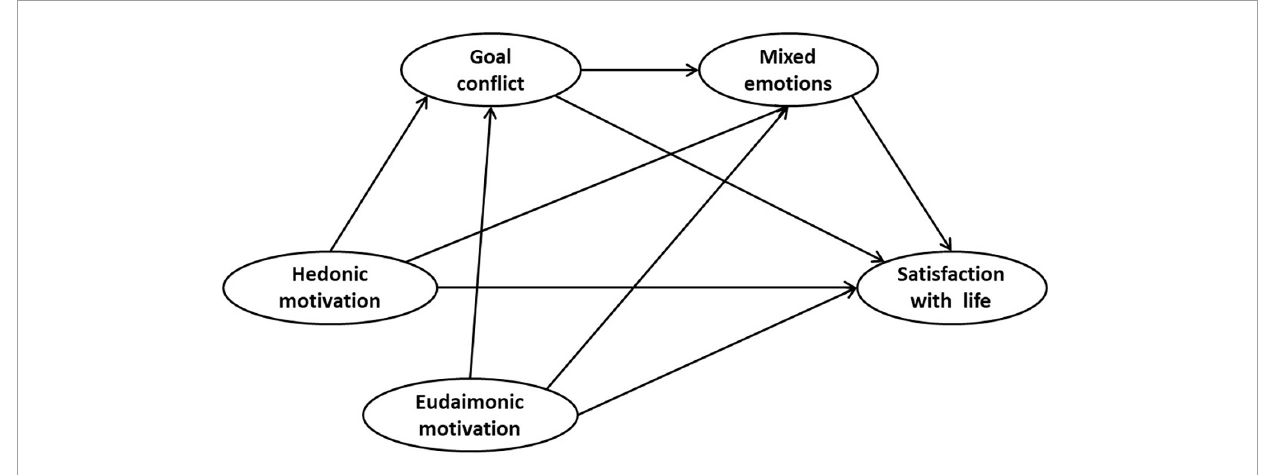
FIGURE1 The theoretical model of chain mediation